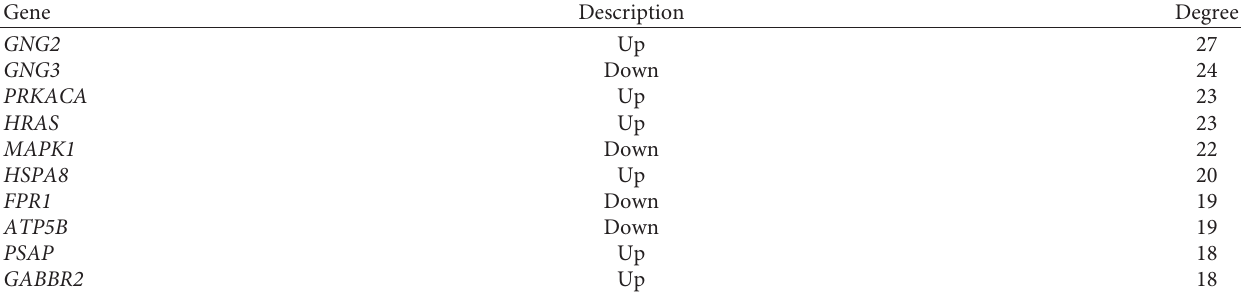
Table 2: List of top 10 differentially expressed genes with higher degrees in the PPI network.